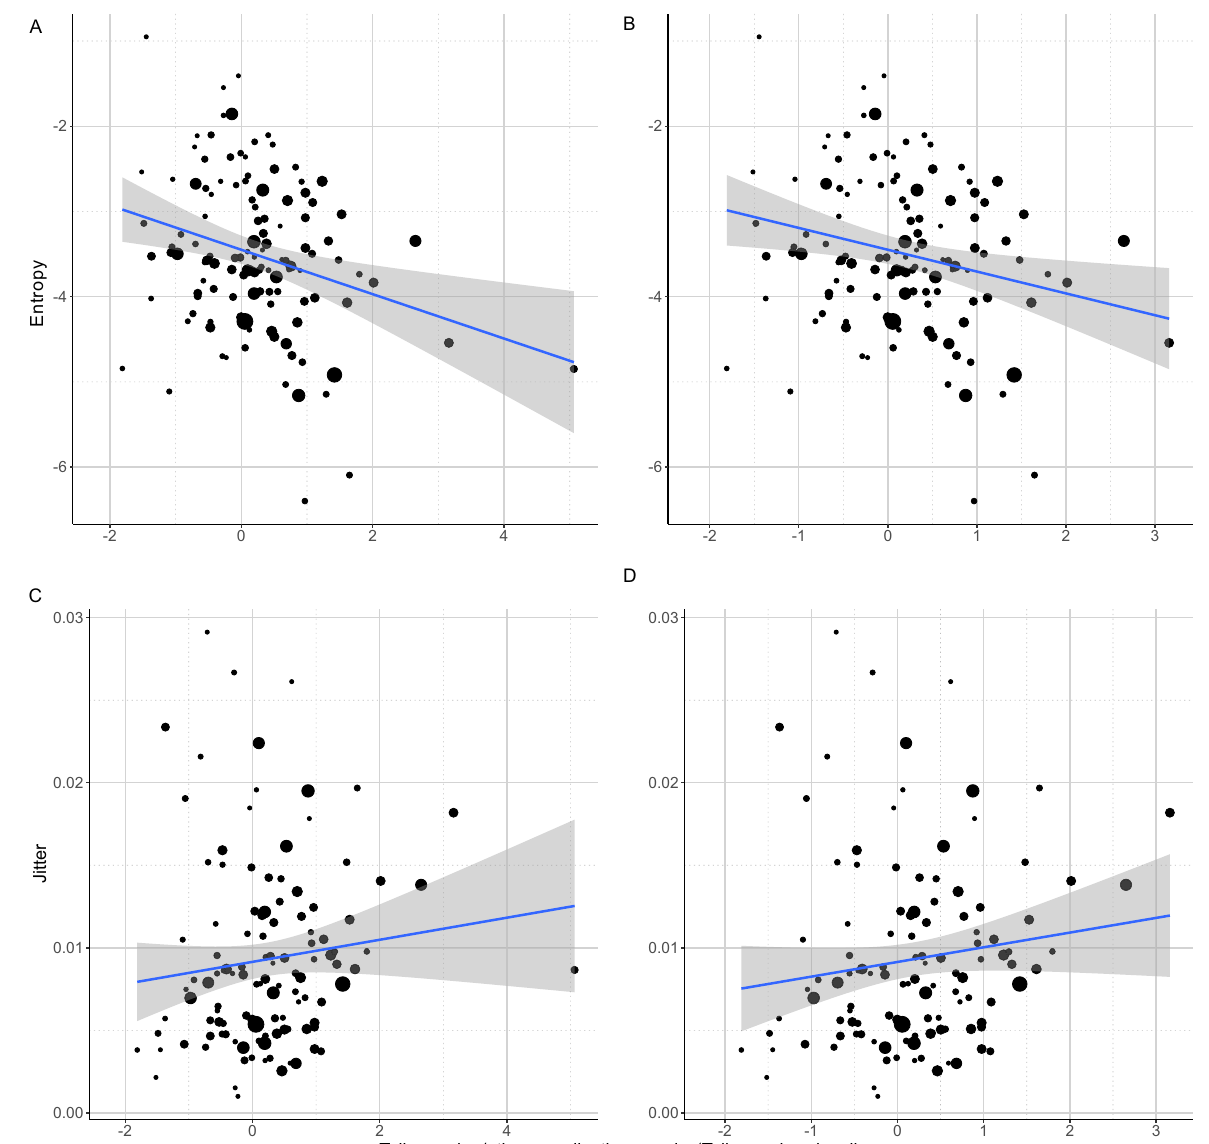
Figure 6. ( A , B ) The negative relationship between the entropy of whines produced by the dog during the separation test and the amount of time spent with tail wagging, other vocalizations and orienting to the door. ( C , D ) The positive relationship between the jitter of whines produced by the dog during the separation test and the amount of time spent with tail wagging, other vocalizations and orienting to the door. The size of the dots is proportional with the number of whines produced. The grey field shows the 95% confidence interval of the linear